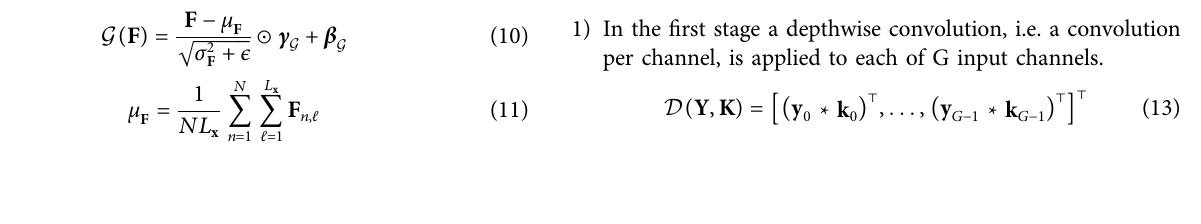
Frontiers in Signal Processing |